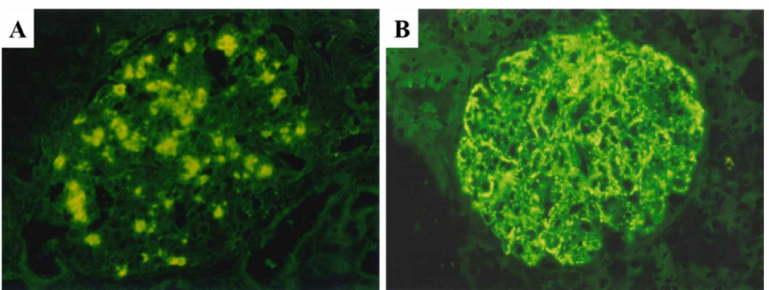
Figure 5. Difference in glomerular localization of NAPlr and immune complexes. ( A ): In the early phase, localization of NAPlr, which is presumed to be a free antigen, is primarily on the mesangium, part of the GBM, and infiltrating neutrophils. ( B ): In the early phase, C3 is localized mainly along the GBM (subepithelial), and partly on the mesangium. Original magnification: × 400. GBM: glomerular basement membrane, NAPlr: nephritis-associated plasmin receptor. Photographs are cited from a previously published report [2], where details of all the staining methods have been described.